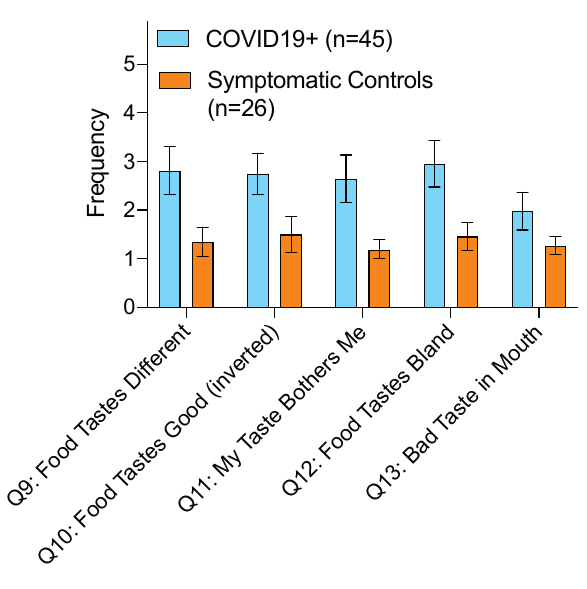
Figure S3. COVID-19 + Patients Reported Higher Frequency of Gustatory Disturbance than Symptomatic Controls at Baseline. There was a signifi- cant difference in self-reported taste symptoms in COVID-19 patients (blue) compared to symptomatic controls (orange). Error bars represent 95% confidence intervals. Questions are answered on a 5-point Likert scale (1=never, 2=rarely, 3=sometimes, 4=often, 5=always). Q9: Food tastes different than I remember. Q10: Food has tasted good. Q11: My sense of taste has bothered me. Q12: Food has tasted bland. I have a bad taste in my mouth. Question 10 was inverted for consistency.